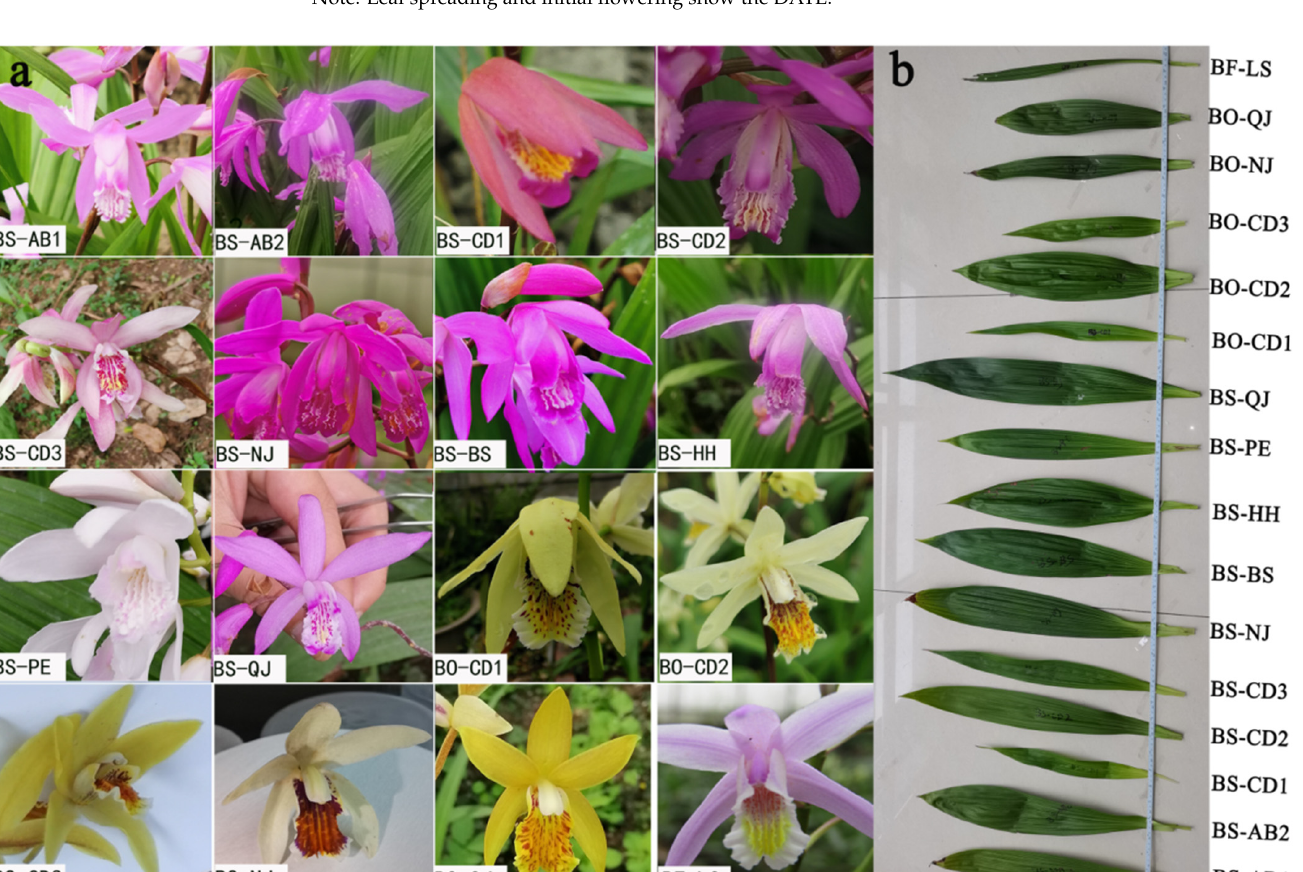
Note: Leaf spreading and initial flowering show the DATE.